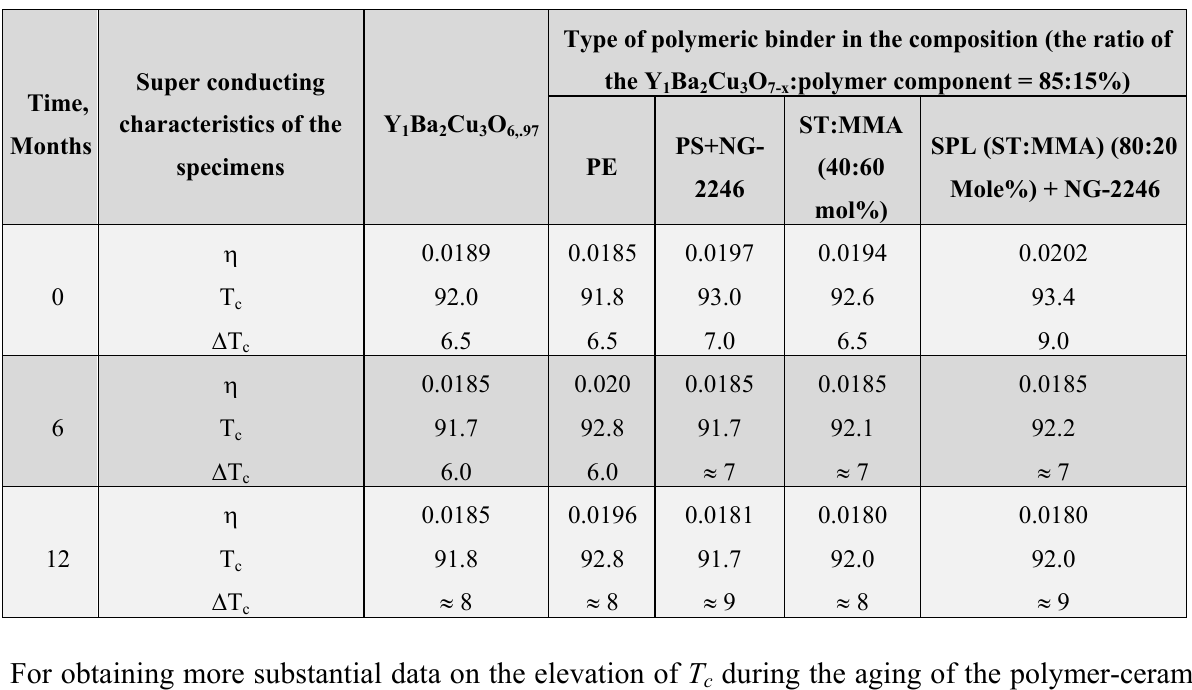
Table 10. Super conducting characteristics of the high-temperature super